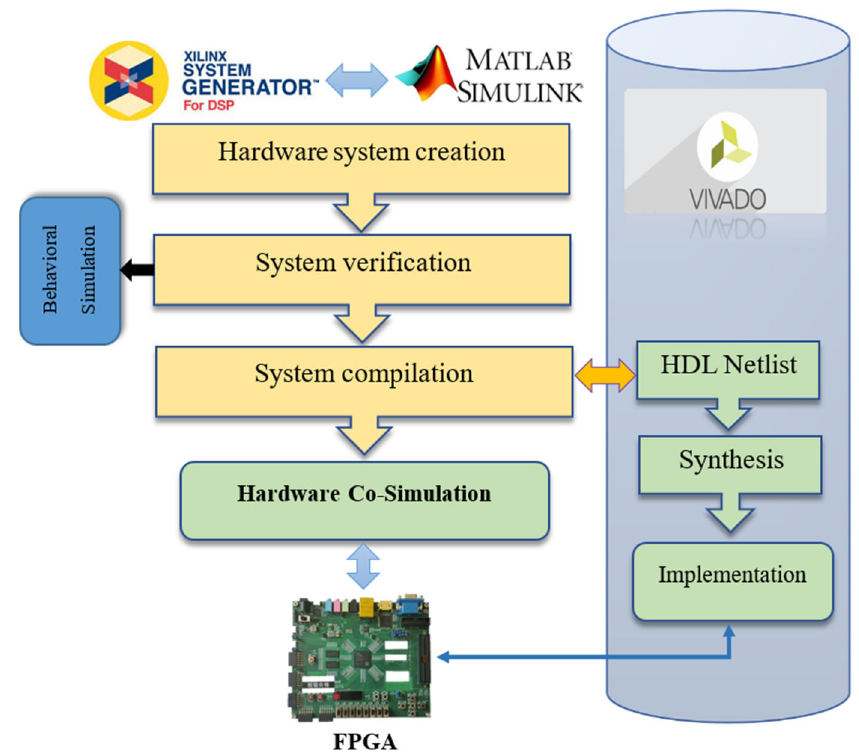
Figure 11. XSG-based design fl ow.